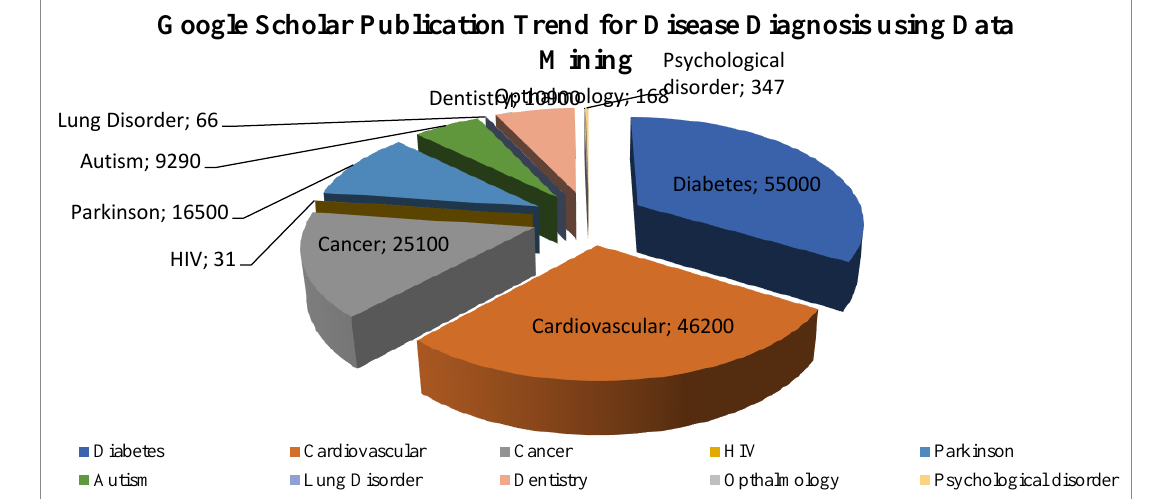
Figure 2: Google Scholar Publication Trend for Disease Diagnosis using